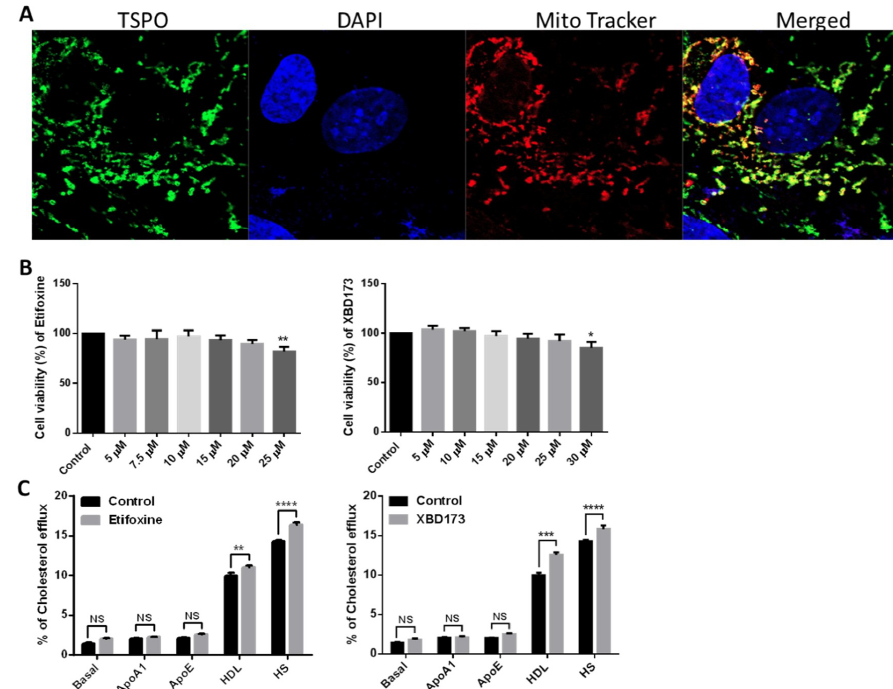
Figure 1. ( A ) The expression and co-localisation of translocator protein (TSPO) and mitochondria in RF/6A cells. RF/6A cells were stained with Mito-tracker (a marker for functional mitochondria) anti-TSPO antibody. Images captured confocally show TSPO (Green), DAPI (Blue), mitochondria (Red), while the Merged image shows co-localisation of TSPO and mitochondria (630 × ). ( B ) Toxic effects of TSPO ligands Etifoxine and XBD173 on RF/6A cells. RF/6A cells were treated with different concentrations of Etifoxine for 24 h and assayed: a decline in cell viability at the concentration of 25 µ M